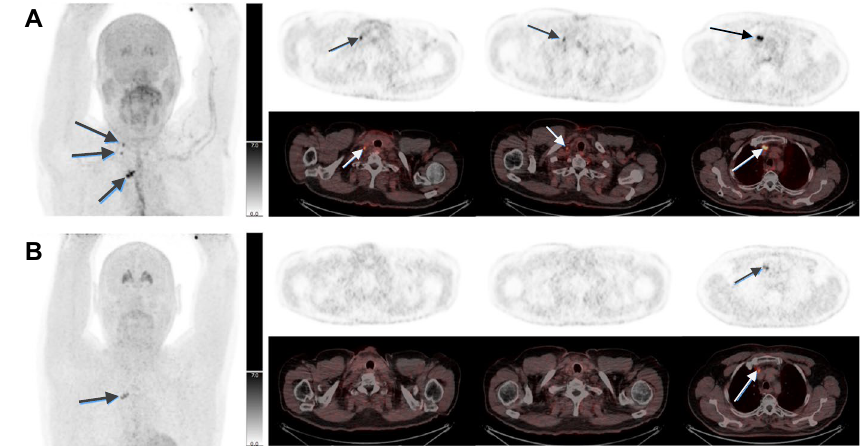
Fig. 5 A 65-year-old man (patient 3). All lesions were verified by biopsies as true positive. A Imaging 15 min p.i. showed focal 18 F-FDOPA uptake corresponding to two cervical lymph nodes (SUV max thoracic lymph nodes (SUV max 10). B 18 F-FDOPA uptake was no longer evident 59 min p.i. in the two = cervical lymph nodes, and uptake in the thoracic lymph nodes was reduced (SUV max